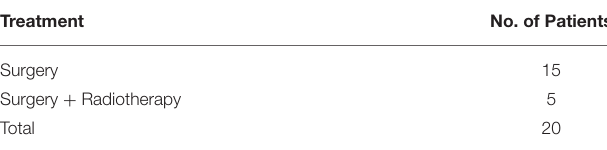
TABLE 2 | Number of pituitary deficiencies in the study population at baseline and after 5-year follow-up.